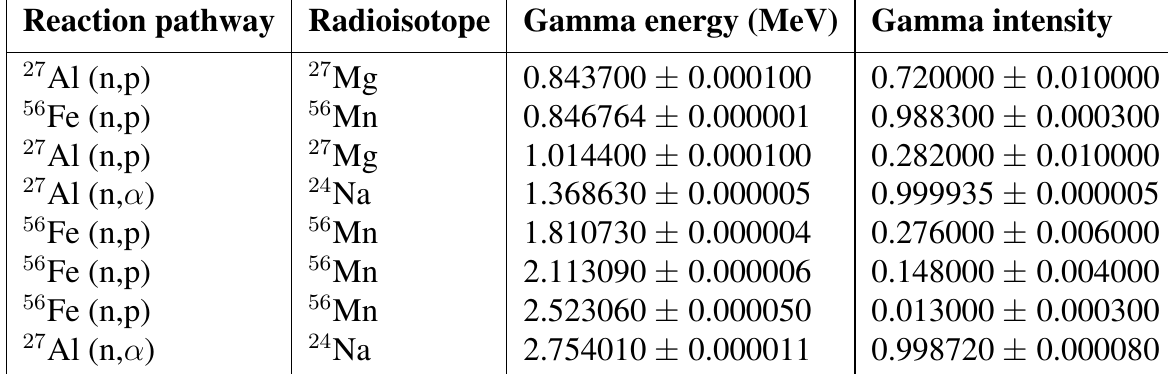
Table 1: The list of reactions and the radionuclides produced for the Aluminum and Iron foils which are used to estimate neutron fluence. Each radioisotopes dominant ( ≥ 1% intensity) gamma decay energies and intensities are shown in the table. Values and uncertainties are based on JEFF 3.3 data values [12][13][14] released with FISPACT-II version